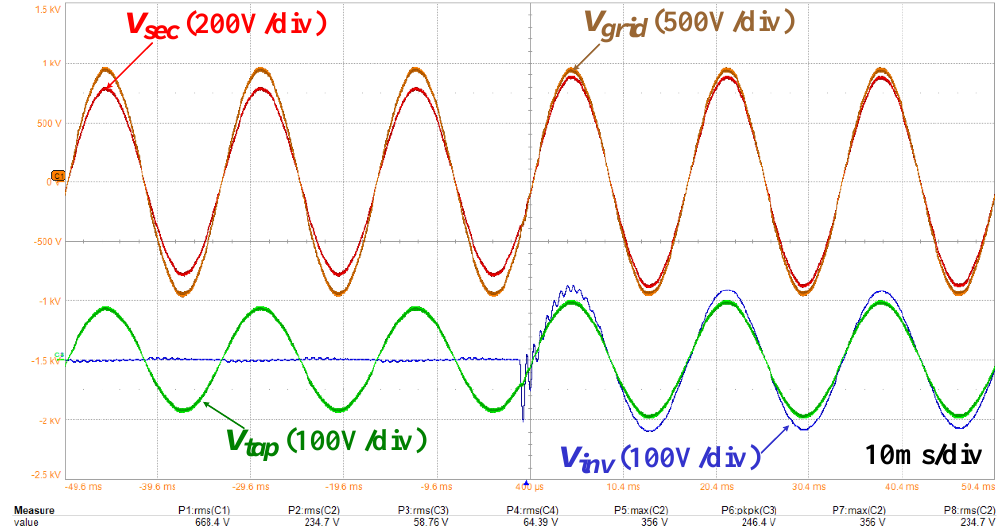
Figure 15. The grid, secondary side, inverter voltage, and grid current at the operation mode change.